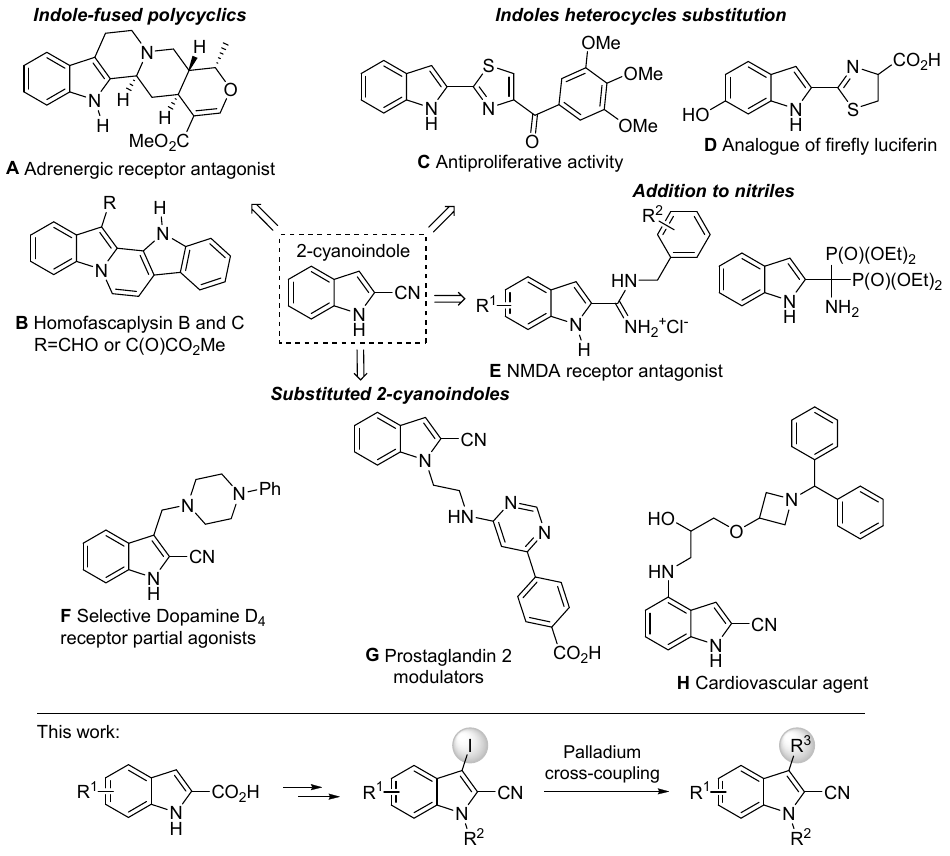
Figure 1. Biologically relevant compounds, featuring 2-cyanoindole cores.